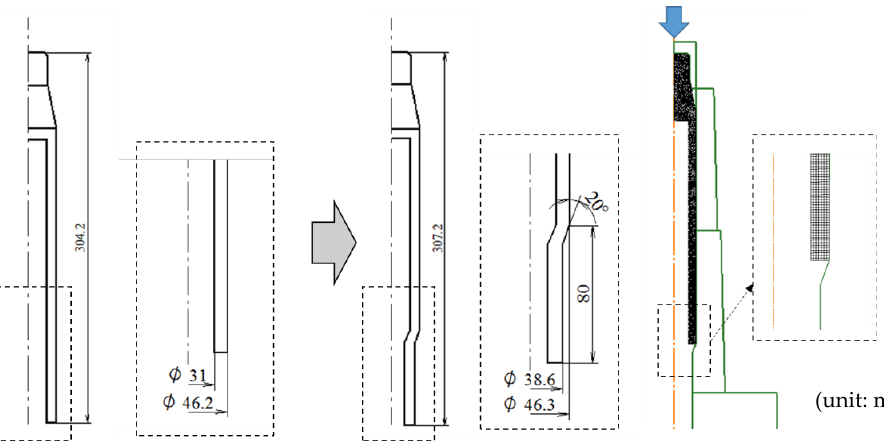
Figure 17. The dimension of first forward extrusion and FEA model.